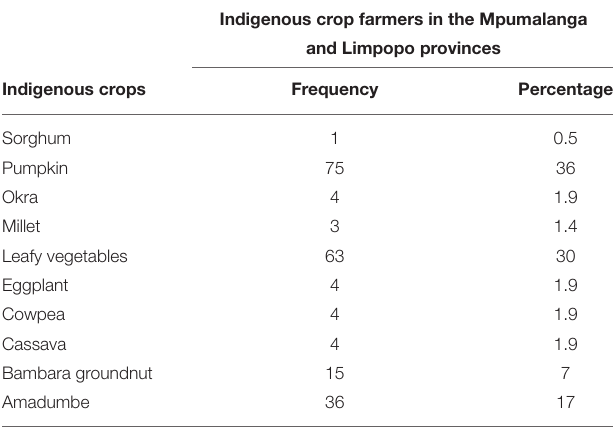
TABLE 4 | Distribution of all indigenous crops that were sold to the market by smallholder farmers. Smallholder indigenous